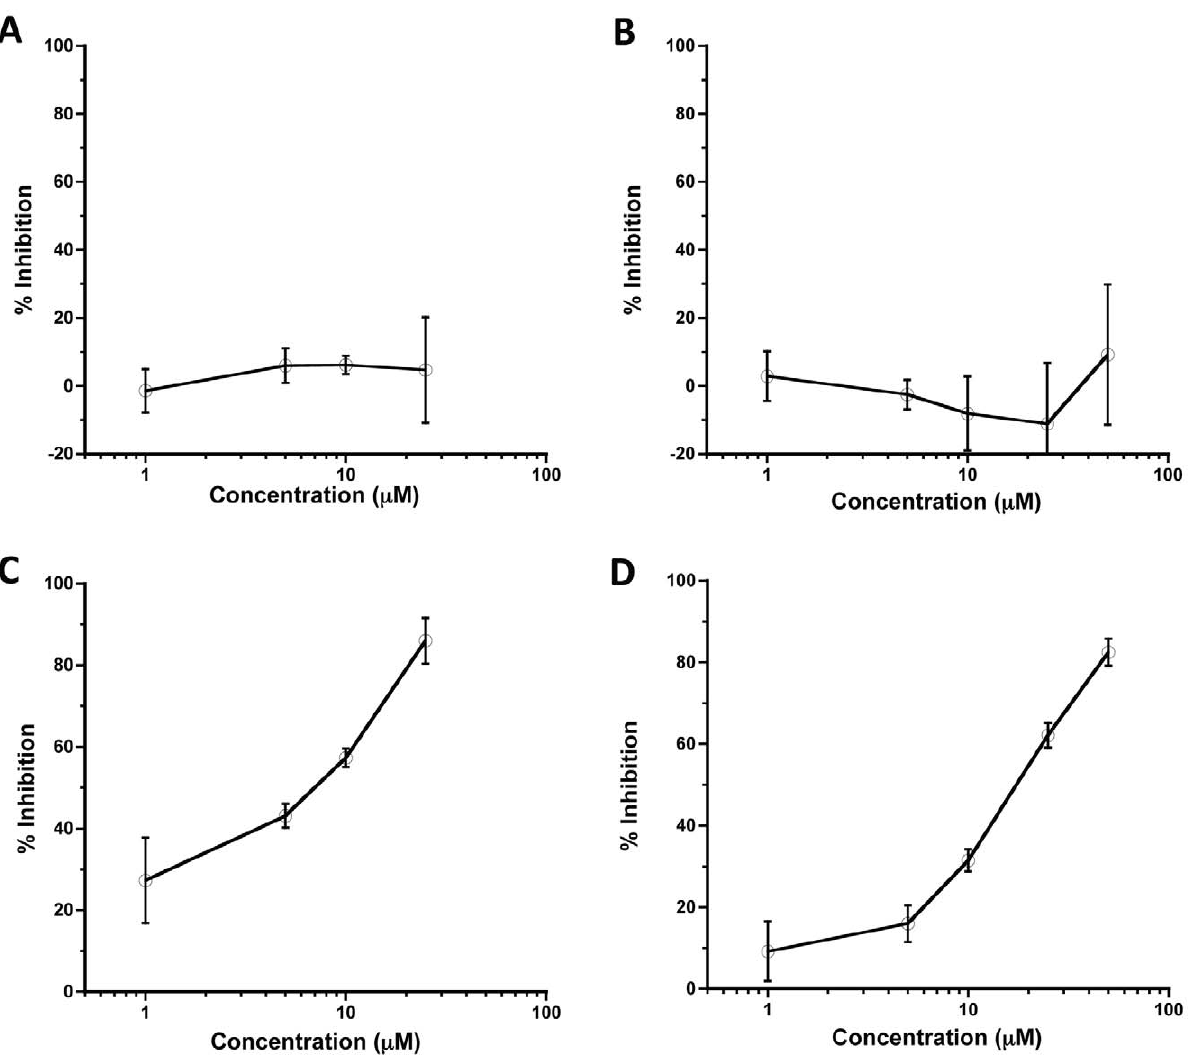
Figure 6. Post-infection and post-binding peptide treatments. Treatment of cells with increasing concentrations of (A) DN57opt and (B) 1OAN1 after DENV-2 has infected cells shows no significant inhibition. Treatment with (C) DN57opt or (D) 1OAN1 after DENV-2 has bound to LLCMK-2 cells at 4 u C for one hour inhibits infection. Error bars are 6 sem.